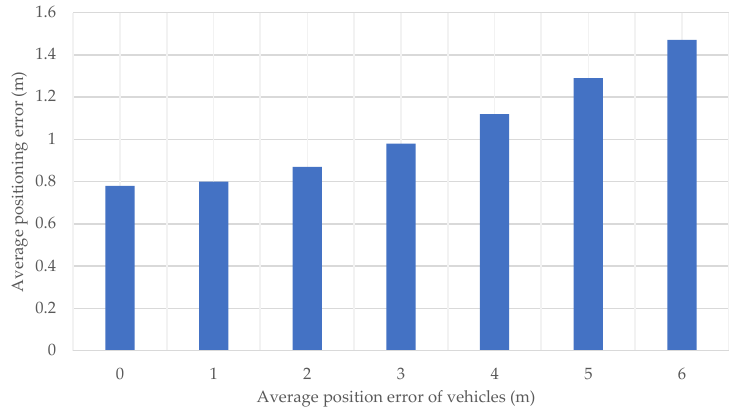
Figure 16. Average horizontal positioning error for each average position error of vehicles.